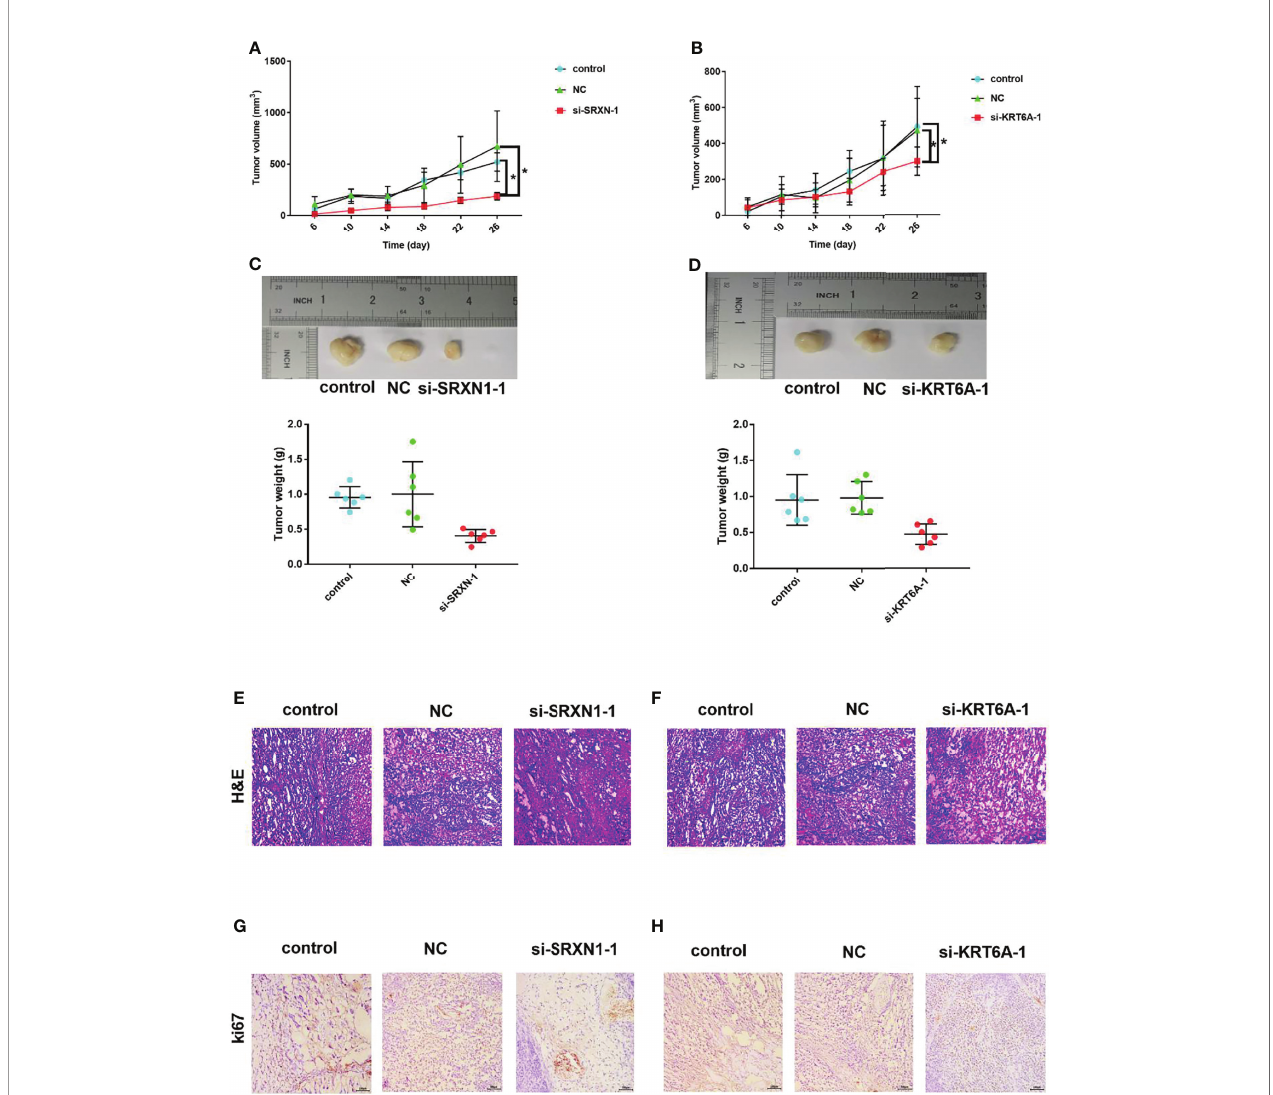
FIGURE 6 | SRXN1 or KRT6A knockdown suppressed tumor growth in vivo . (A) Tumor growth curve in response to SRXN1 depletion. (B) Tumor growth curve in response to KRT6A depletion. (C) Representative images of xenograft tumors from nude mice and comparison of tumor weights in response to SRXN1 depletion. (D) Representative images of xenograft tumors from nude mice and comparison of tumor weights in response to KRT6A depletion. (E, F) Representative images of hematoxylin – eosin-stained tumor samples from SRXN1 and KRT6A knockdown samples, respectively, relative to controls and negative controls (NC). (G, H) Representative images of Ki67- immunostained tumor samples from SRXN1 and KRT6A knockdown samples, respectively, relative to controls and NCs. * P <